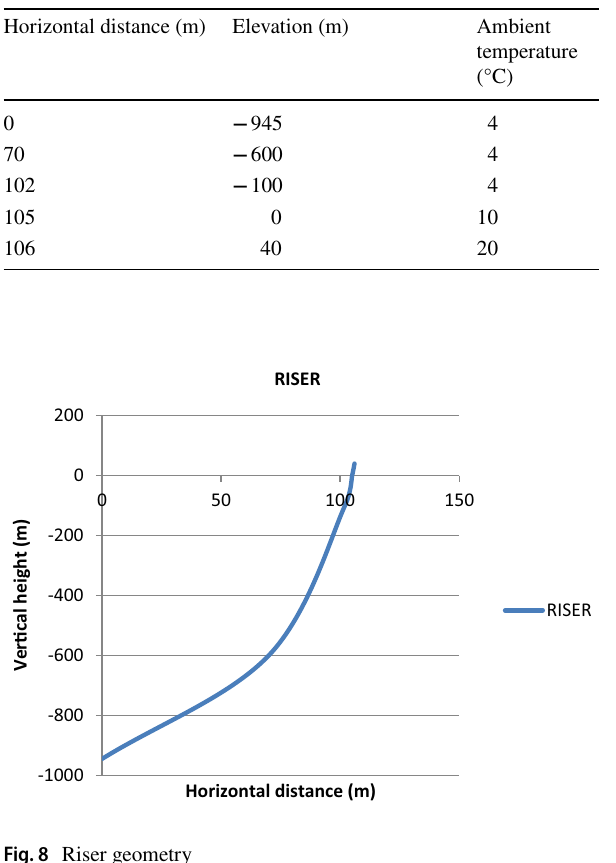
Fig. 8 Riser geometry